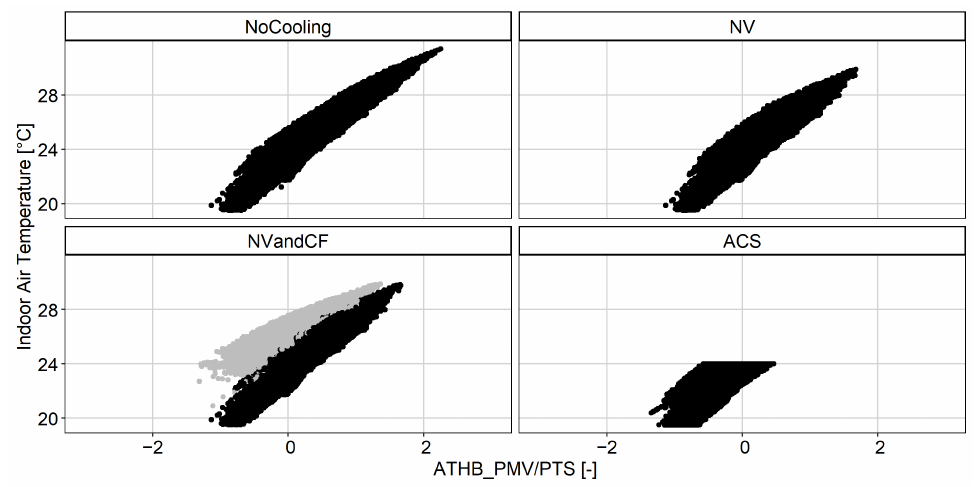
Figure 4. PMV (ACS) and PTS (NoCooling, NV, NVandCF) values vs. indoor air temperature using the ATHB model (black points). The grey points correspond to the data when the ceiling fan was active.